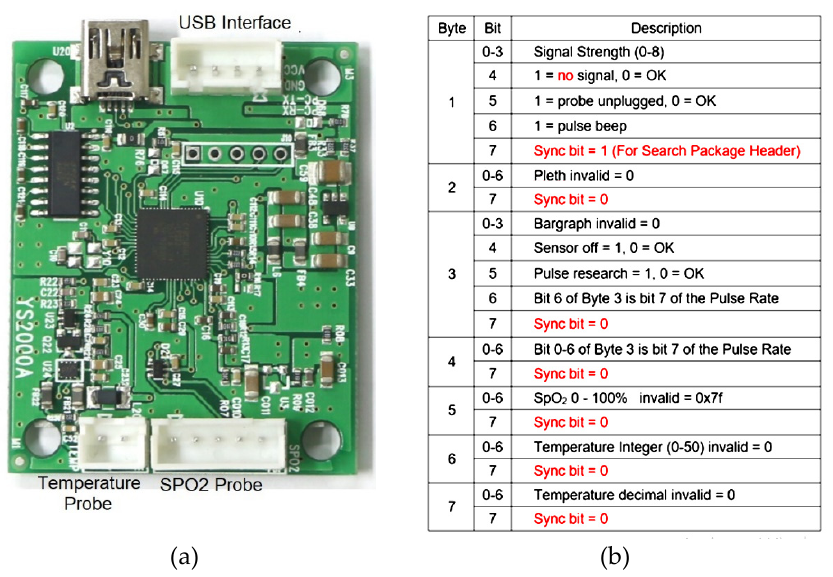
Figure 5. ( a ) YS2000A SpO2 module. ( b ) Serial interfacing protocol used for communicating with microcontroller contains 8 bytes. Byte 4 is the pulse, and byte 5 is SpO2.